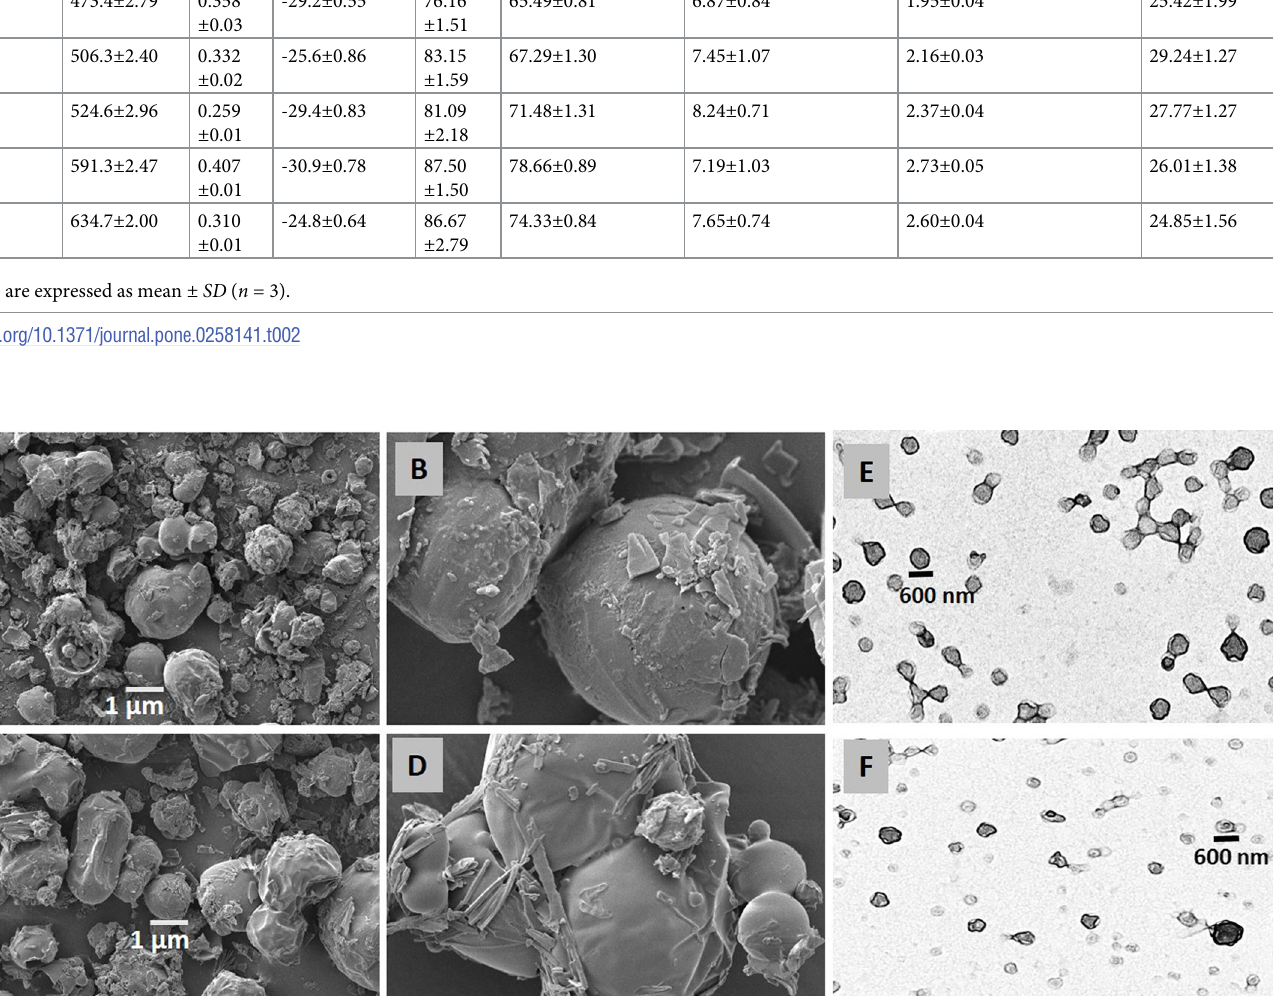
PLOS ONE | https://doi.org/10.1371/journal.pone.0258141 October 19, 2021 8 /